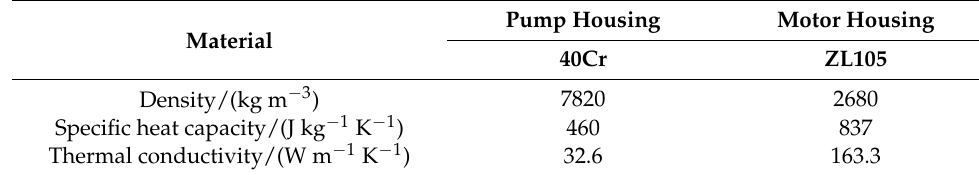
Table 1. Physical properties of material for shell of CCAPT.